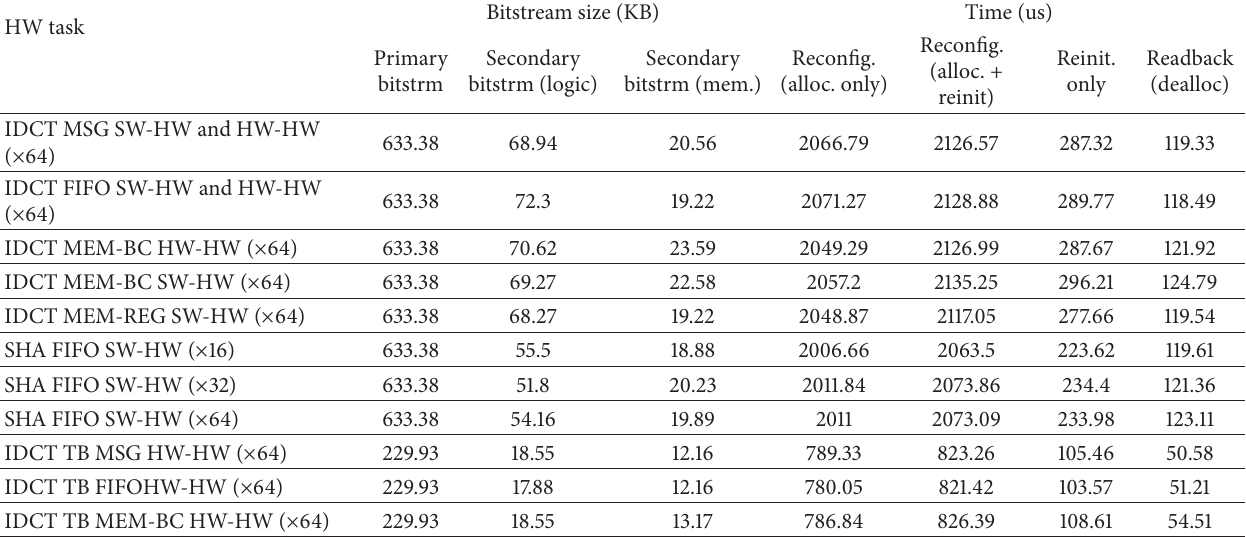
Table 8: HW tasks size of bitstreams and reconfiguration/readback